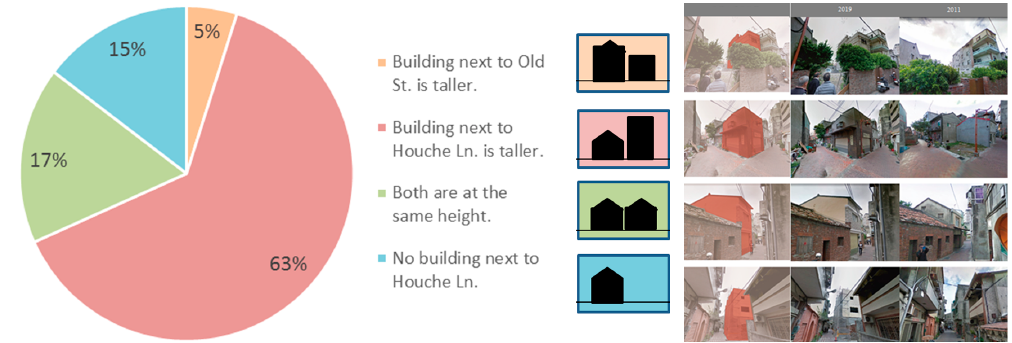
Figure 6. The four volumetric combinations of the constructions on Old Street and Houche Lane ( left ), and the new constructions that occurred on Houche Lane between 2019 and 2011 ( right ).